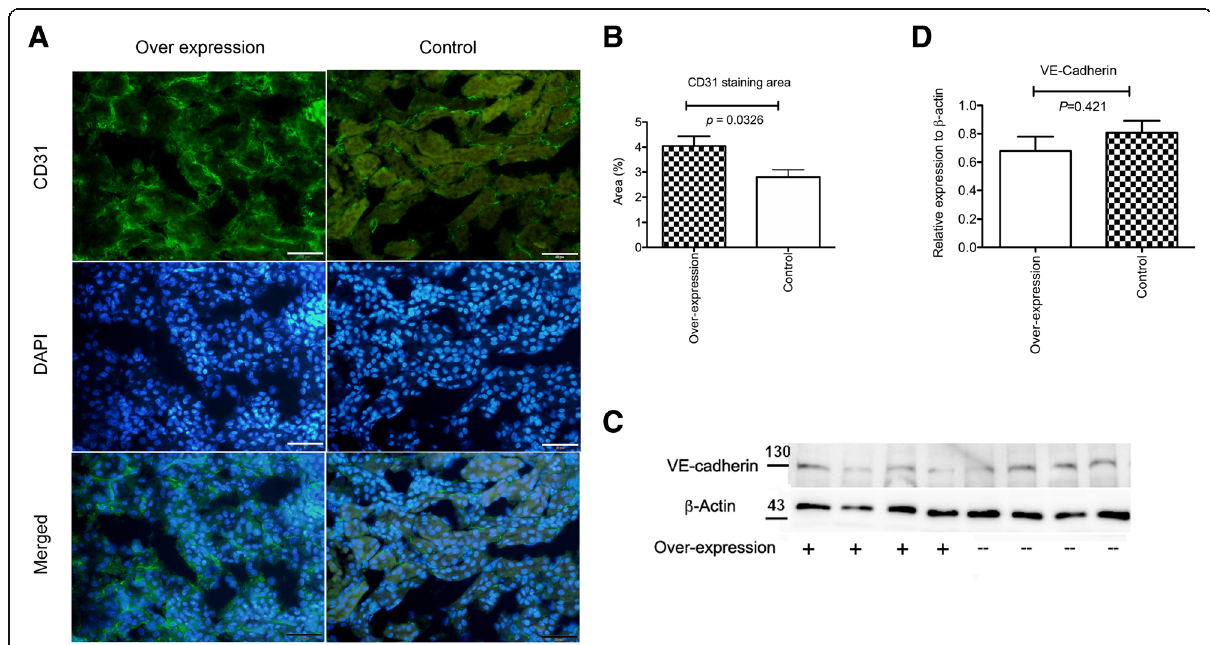
Fig. 8 a & b CD31 endothelial staining and semi-quantitative analysis of the CD31 positive area 1 days after IRI in the control and over expression mice. The CD31 staining was more prominent in the over expression mice. ( N = 15 per group, P = 0.033) c & d VE-cadherin protein expression 1 days after IRI in the control and over expression mice. The protein expression of VE-cadherin did not differ between the control and over expression mice ( N = 4 per